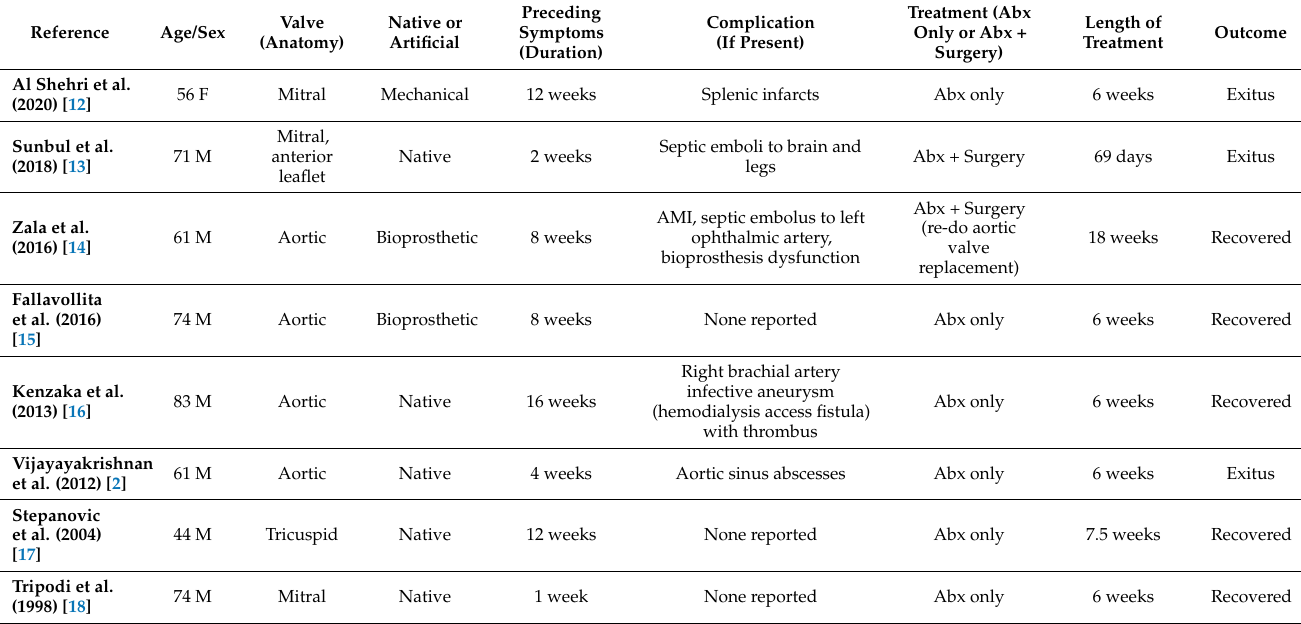
Table 1. Summary of published E. durans endocarditis case